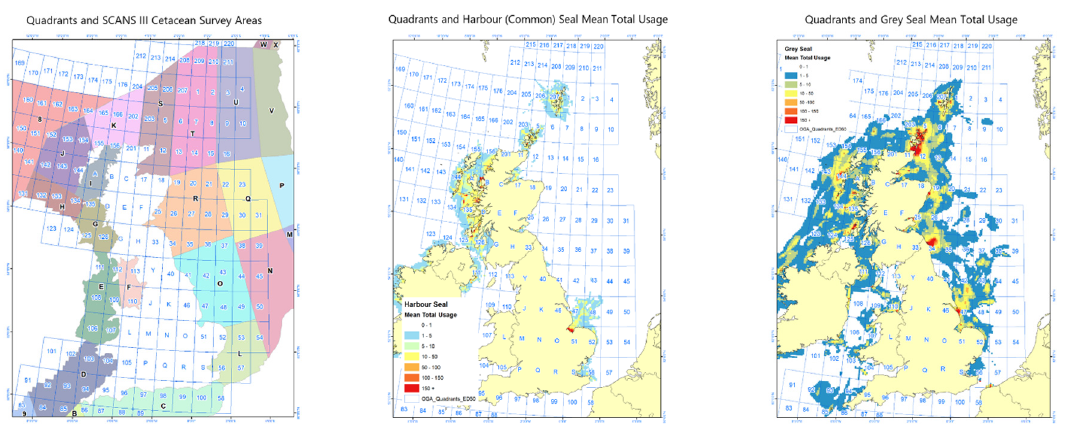
Figure 1. EDGAR Marine mammal risk assessment maps. Adapted from [43,57,58].